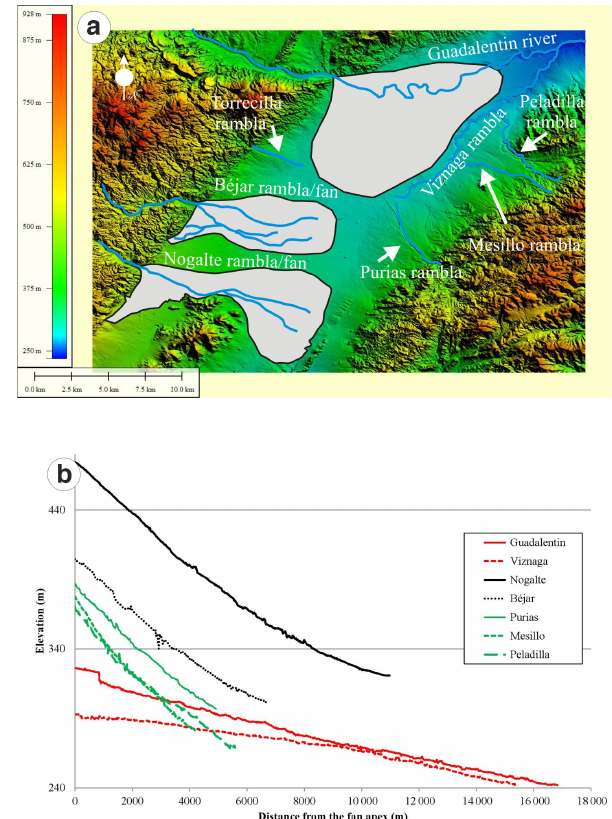
Figure 2. (a) Location of the main streams in the Guadalentín Up- per Depression. (b) Longitudinal profiles of the main streams. Black lines: tributaries of the left margin. In green: tributaries of the right margin. In red: streams in the Guadalentín valley